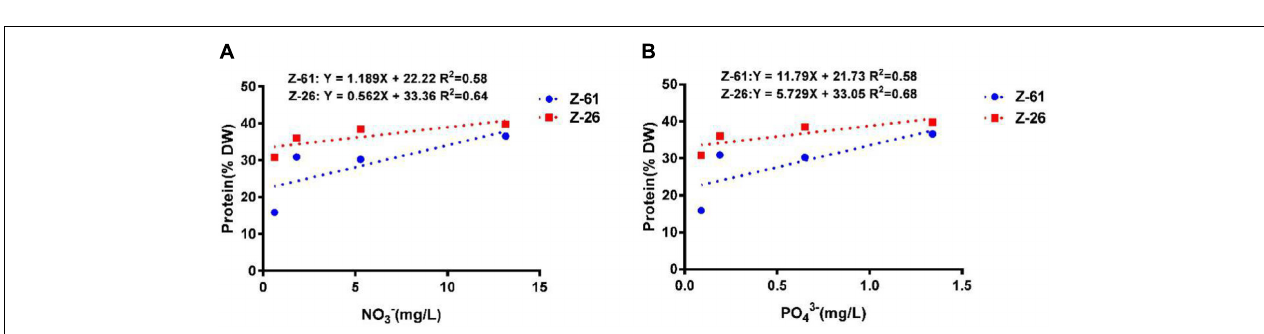
FIGURE 4 | Total protein contents in thalli of Z-61 (A) and Z-26 (B) cultured at different nutrient levels. From N0P0 to N3P3, the NO 3 − contents were 0.61, 1.81, 5.29, and 13.16 mg/L, while the PO 43 − contents were 0.09, 0.19, 0.65, and 1.34 mg/L, respectively. Values are means ± SD ( n = 4). Different letters represent significant differences ( P < 0.05) among treatments. DW: dry weight.